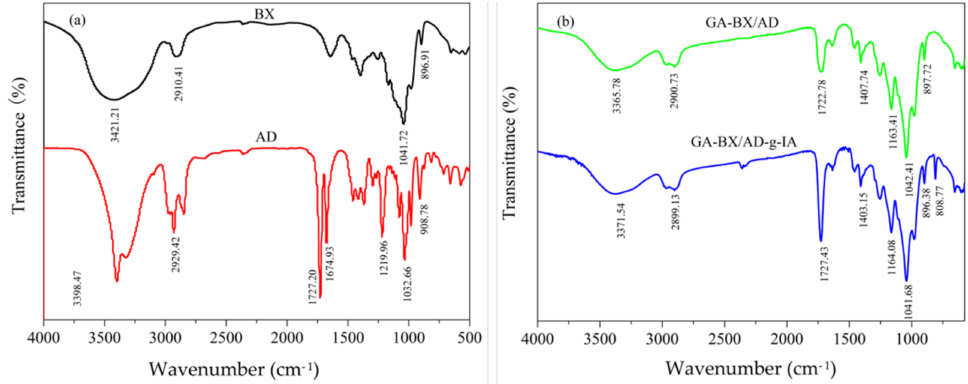
Figure 4. ( a ) FT-IR spectra of BX and AD. ( b ) FT-IR spectra of GA-BX/AD and GA- BX/AD-g-IA.